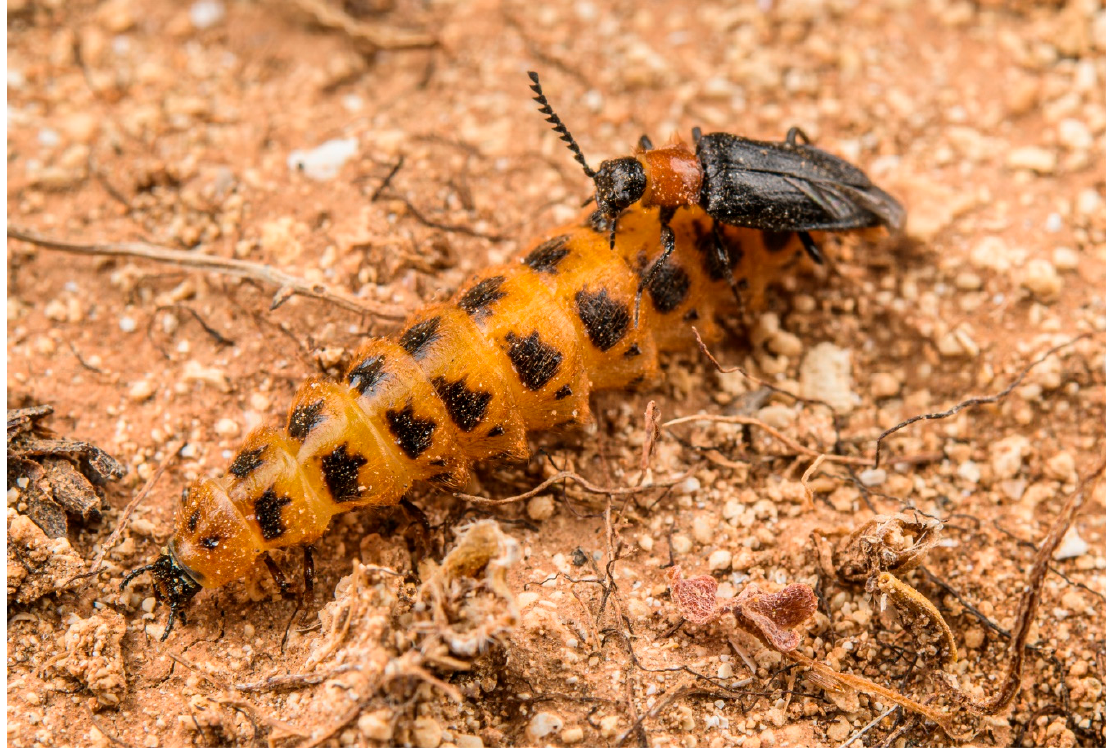
Figure 1. Mating couple of Malacogaster sp. (cf. passerinii ) in Cala Galera on the island of Lampedusa (14 April 2018). Photograph courtesy of E. Biggi (www.anura.it (accessed on 5 April 2022)).